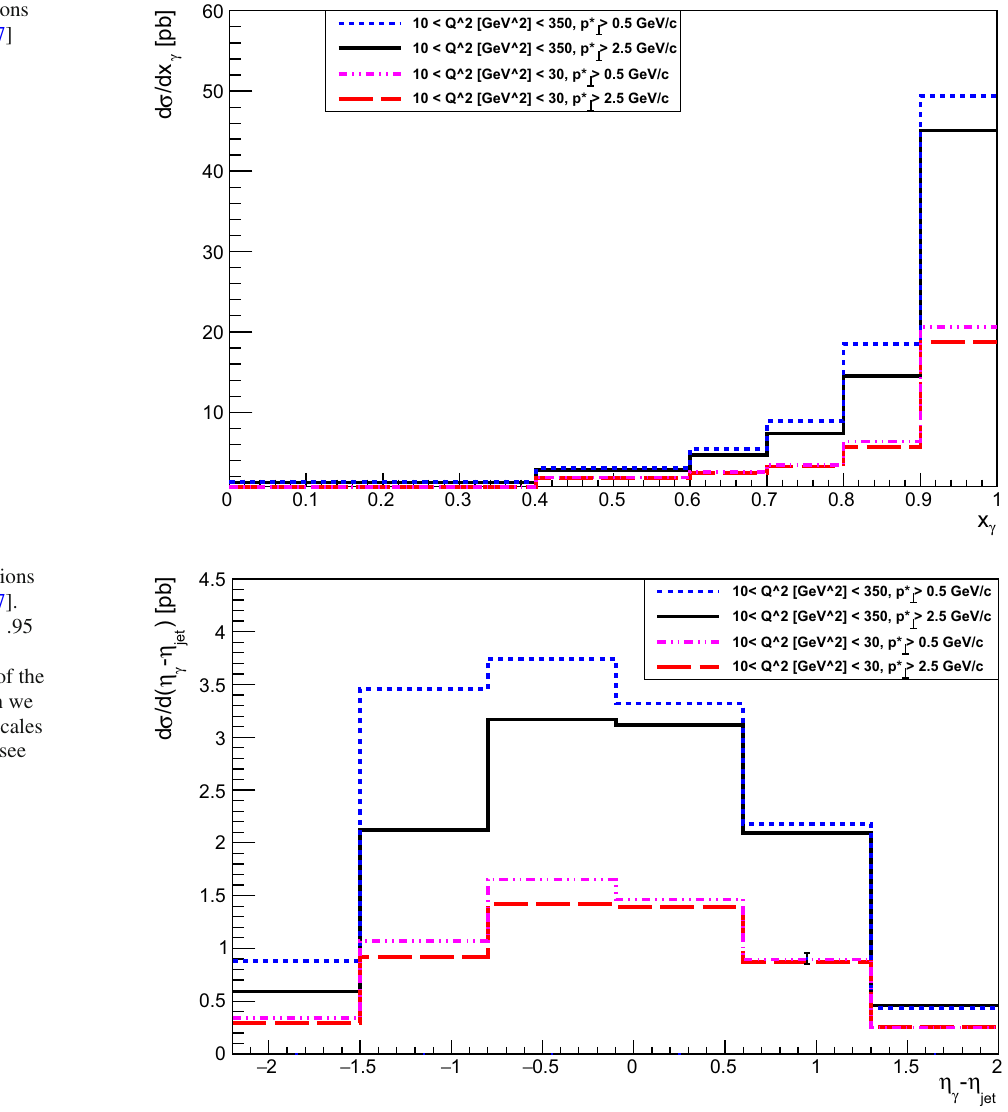
Fig. 2 d σ/ d (cid:4)η cross